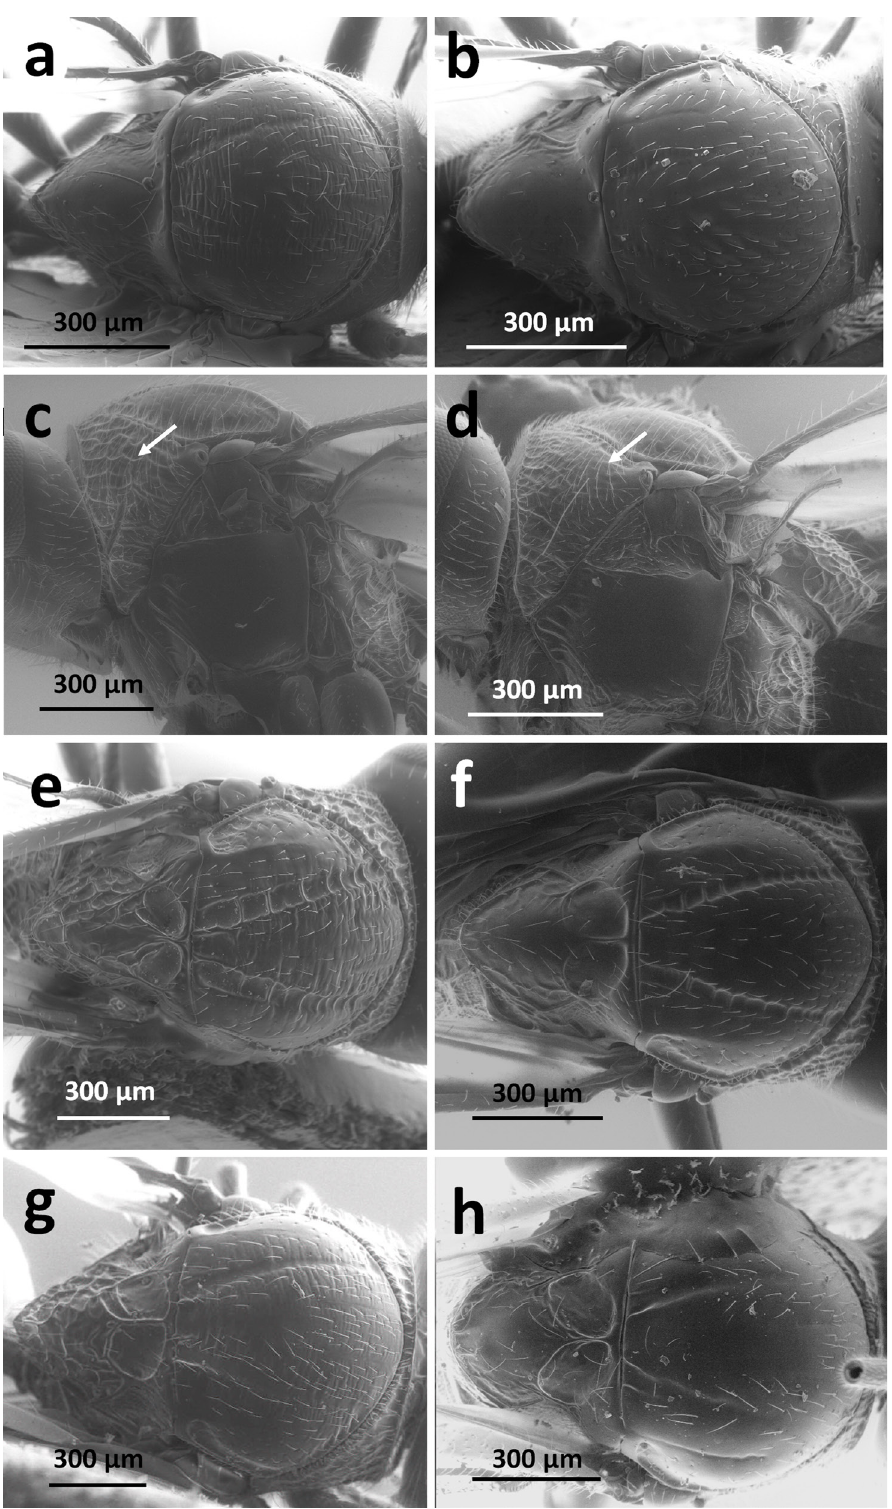
Fig. 2. a . Aegilips insularis Mata-Casanova & Pujade-Villar sp. nov, 2014, ♂, mesosoma in dorsal view. b . A. insularis , ♀, mesosoma in dorsal view. c . A. romseyensis Fergusson, 1985, mesosoma in lateral view. d . A. nitidulus Dalman, 1823, mesosoma in lateral view. e . A. kozlovi Kovalev, 1974. f . A. romseyensis . g . A. nitidulus . h . A. zaitzevi Kovalev,